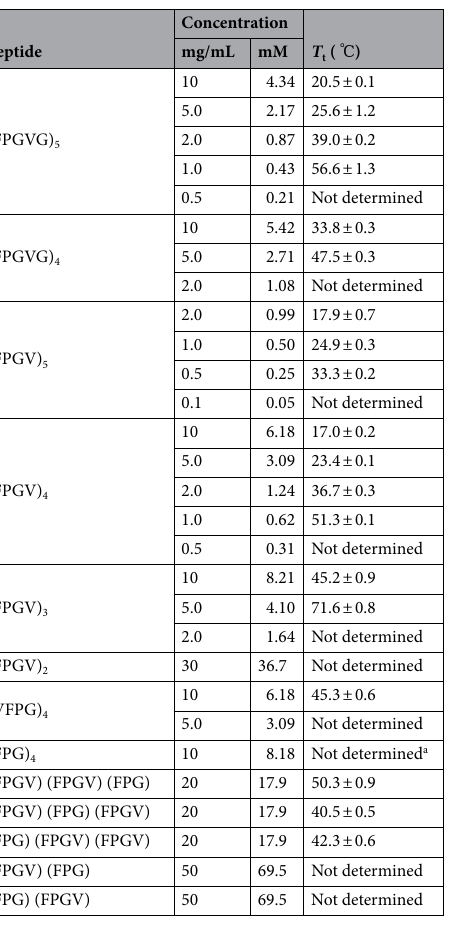
Table 1. The phase transition temperature ( T t ) values of truncated ELP analogues. Mean T t values with SE were shown in the table. Each peptide was dissolved in phosphate buffer (27.4 mM Na 2 HPO 4 , 17.8 mM NaH 2 PO 4 , pH 7.4). The measurements were repeated at least three times. a Since this peptide analogue showed irreversible aggregation and formed insoluble filamentous aggregates, T t value could not be